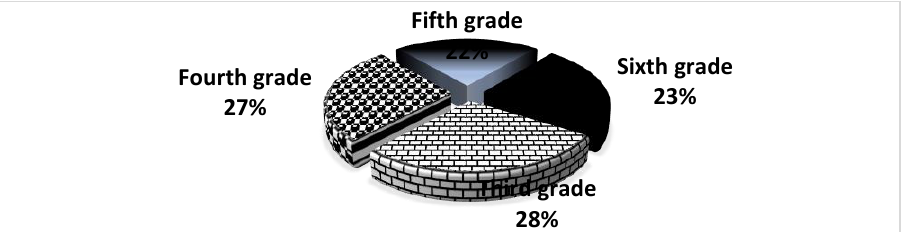
Figure 1. The size of the sample across school grades Source: the authors' study